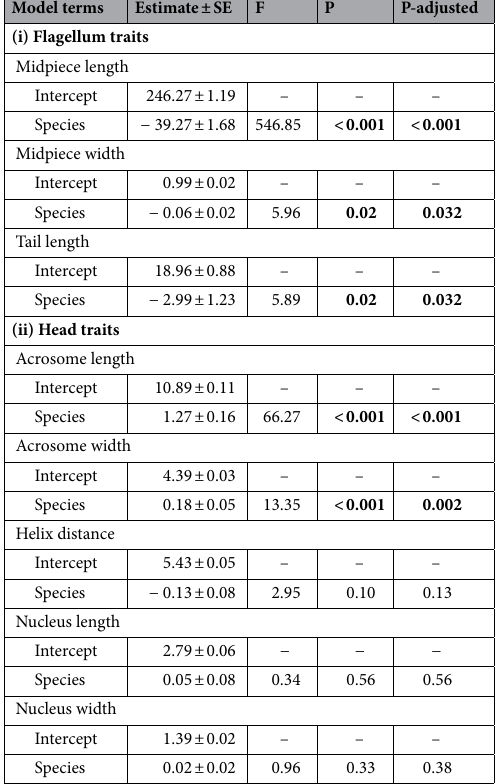
Table 1. Reduced linear mixed models (with excluded effect of region) testing for the effect of species on sperm morphological traits. The common nightingale was a reference species. Measurements were made on photos from confocal microscope. Estimates, standard errors (± SE), F-stats, P-values and adjusted P-value based on Benjamini–Hochberg correction (P-adjusted) are shown for all models. Significant P-values are in bold.